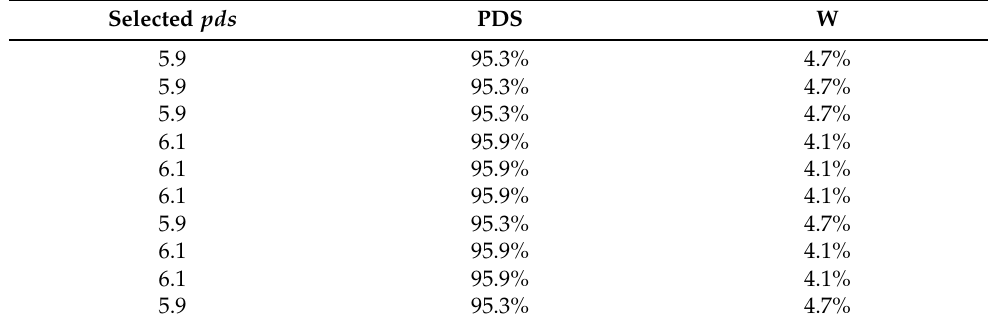
Table 11. Results of the selected pds and served customers depending on the vehicle type.